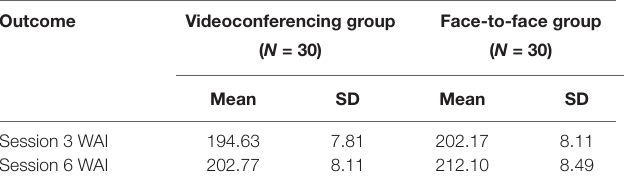
TABLE 3 | Means and standard deviations for the working alliance inventory in the videoconferencing and control conditions ( N = 60). Outcome Videoconferencing